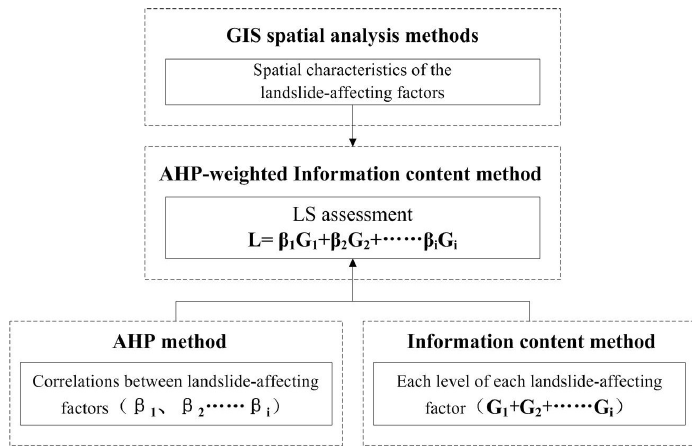
Figure 3. Landslide susceptibility (LS) assessment based on geographic information system (GIS) and the analytic hierarchy process (AHP)-weighted information content method.